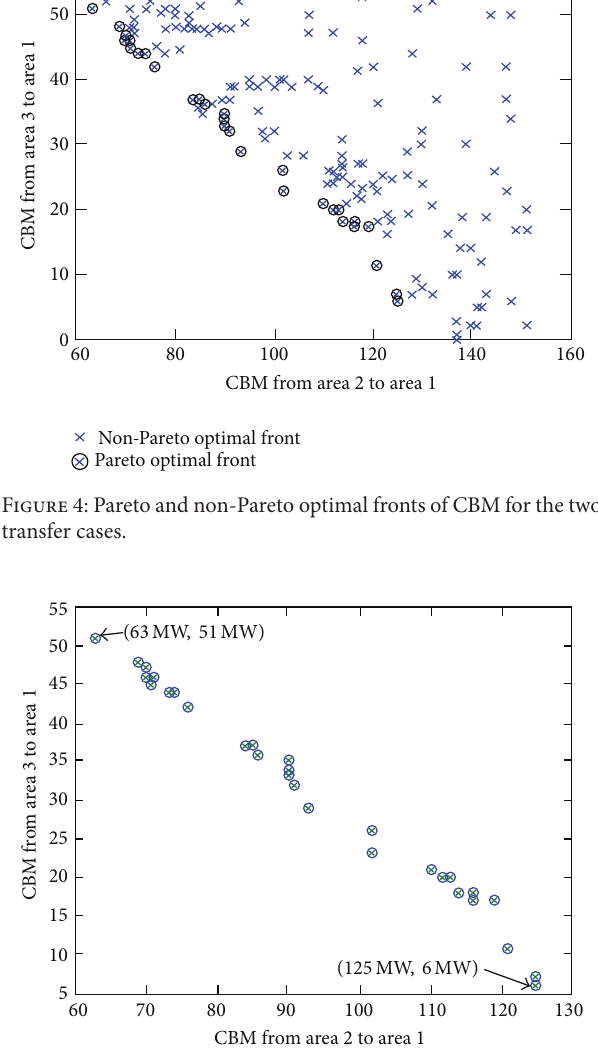
Table 5. Every result of Pareto optimal front CBM will be